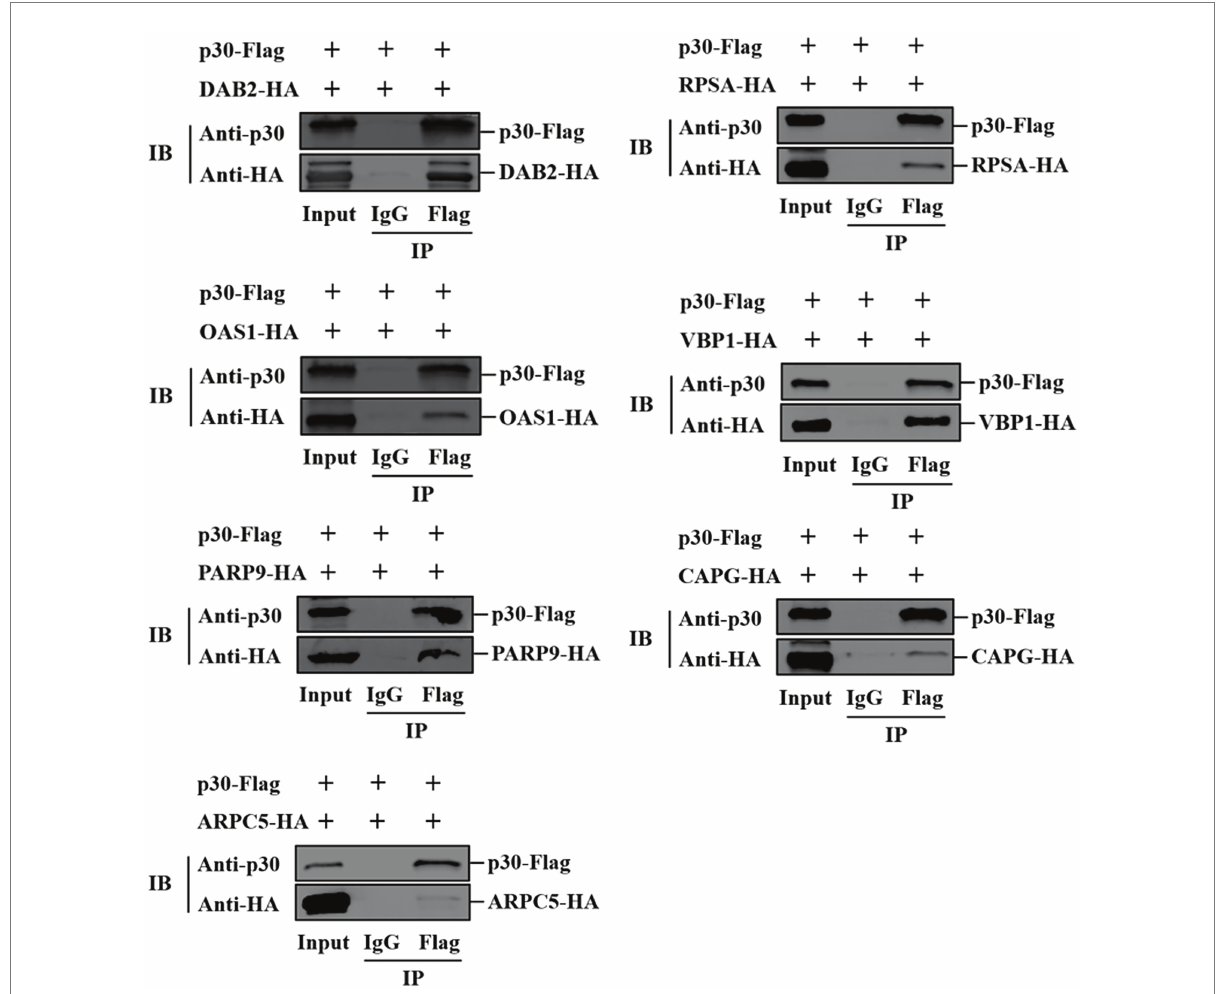
FIGURE 3 Verification of ASFV p30-cell protein interaction using Co-IP. HEK-293T cells were co-transfected with plasmids expressing HA-Dab2, HA-RPSA, HA-OAS1, HA-VBP1, HA-PARP9, HA-CAPG, or HA-ARPC5, and plasmids expressing Flag-p30. Cell lysates were immunoprecipitated with IgG and anti-Flag antibodies, followed by immunoblotting with anti-HA antibodies. The first lane indicates the input group, the second lane is the IgG control group, and the third lane is the experimental